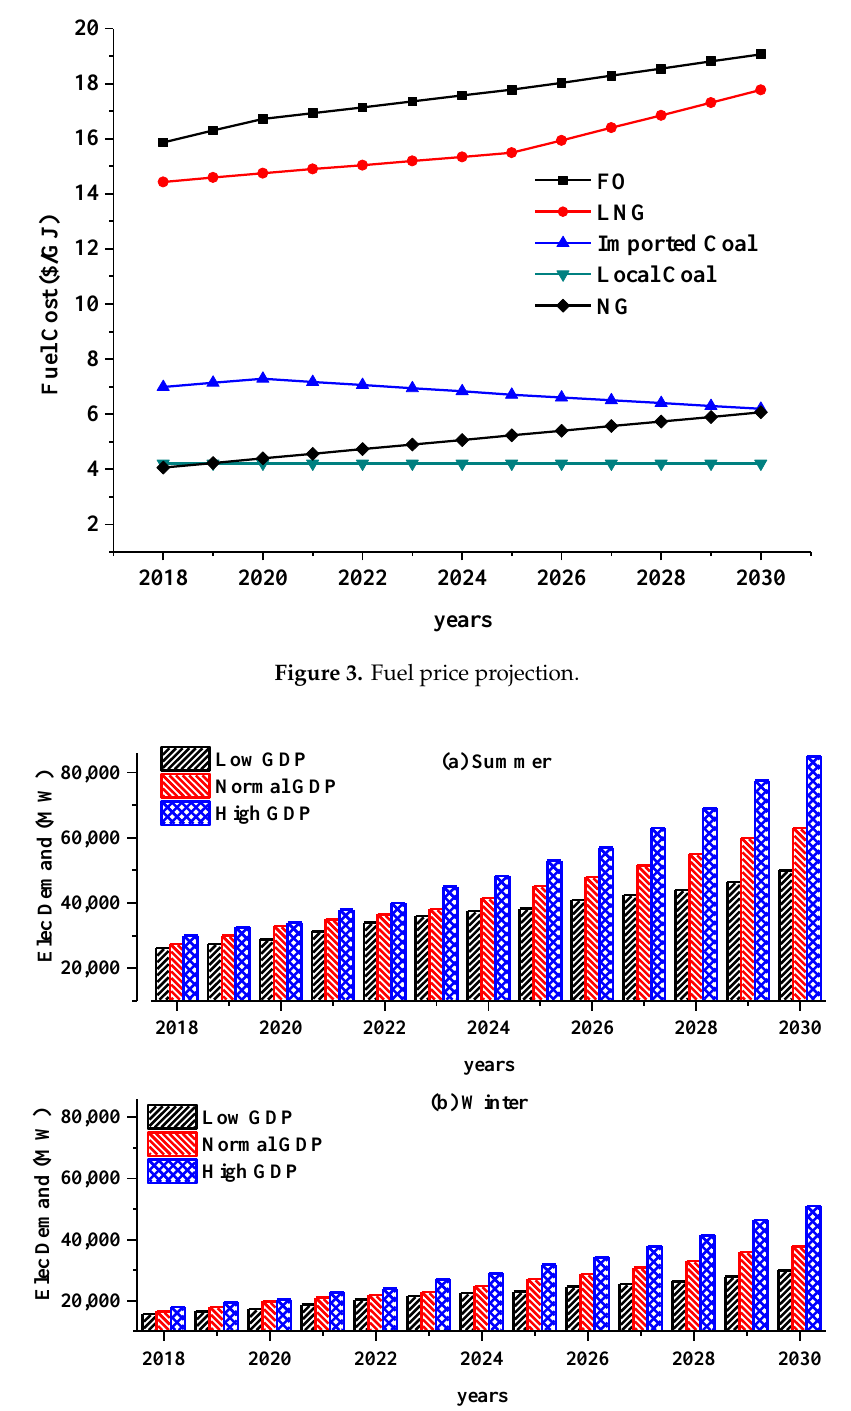
Figure 3. Fuel price projection.